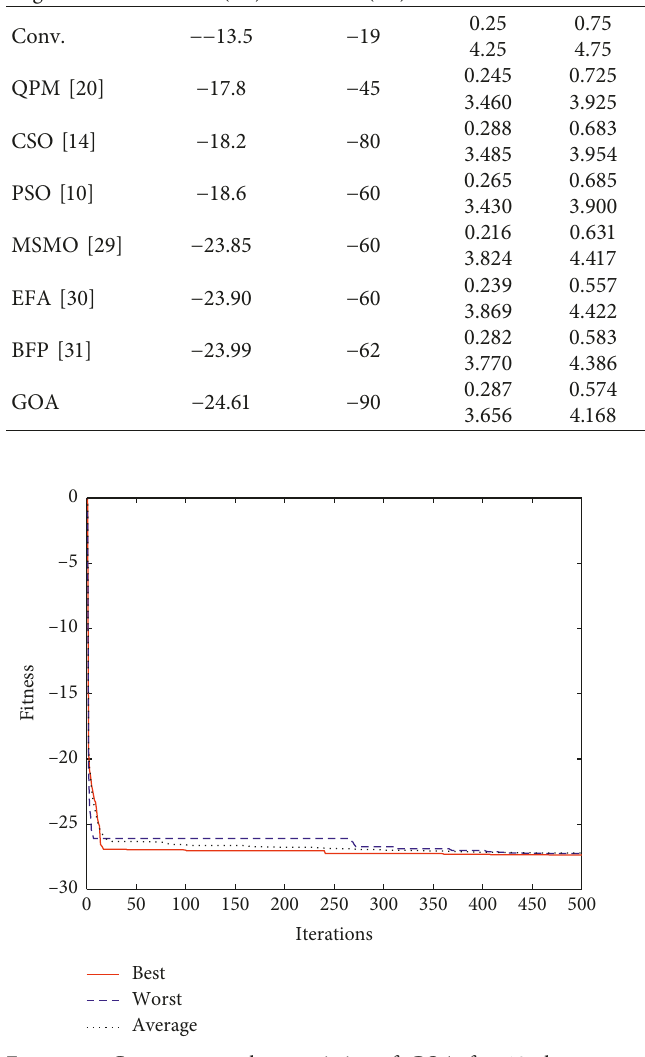
Table 3: The maximum SLL of linear array and the location of each element after optimization. Algorithms